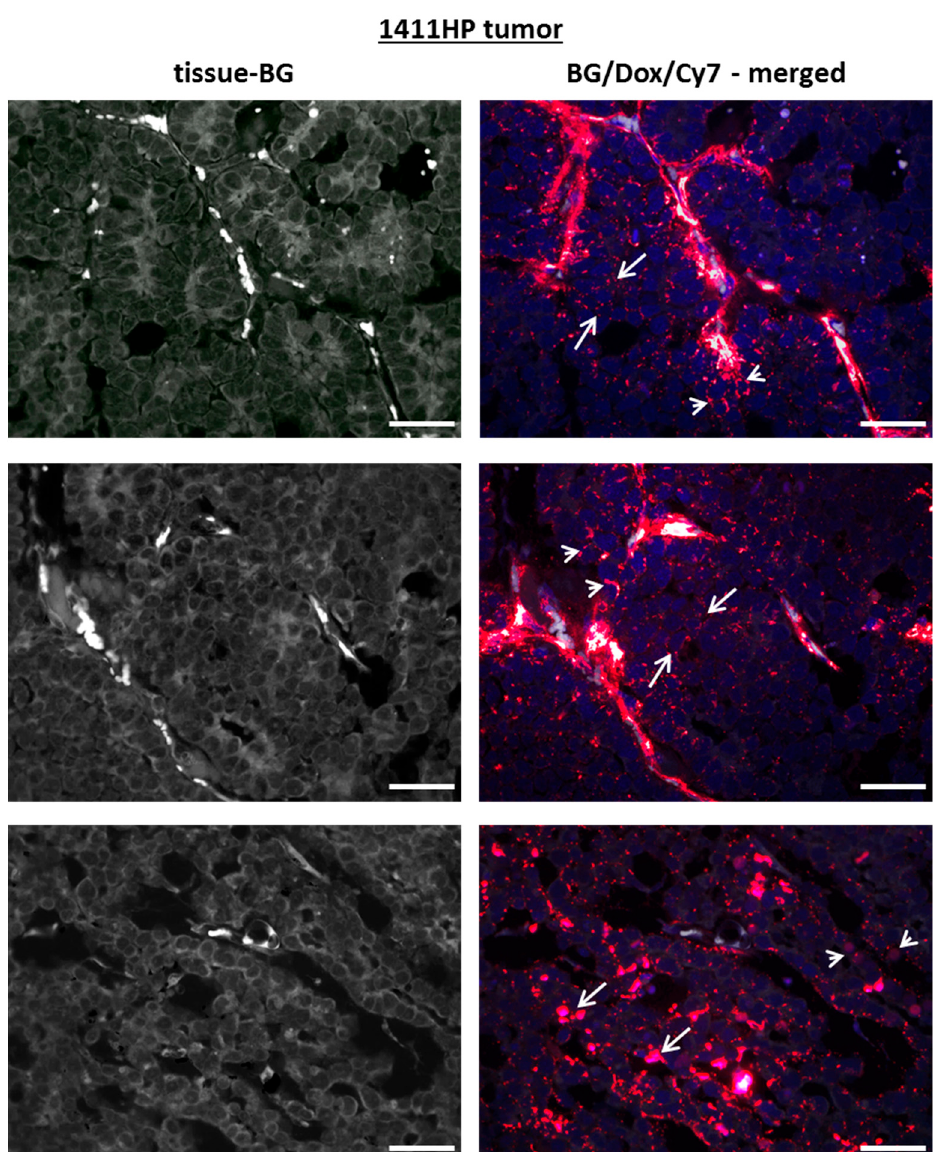
Figure 7. Specific pattern of distribution in the 1411HP tumor type. Depicted are three examples representing the main features of distribution found in the 1411HP tumor type 24 h after injection of the pHPMA-Dox-Cy7 conjugate. Images on the left side show the tissue background, respectively. On the right side, merged images of isolated Dox (blue) and polymer carrier (red) derived signals together with the tissue background are shown, respectively. A substantial amount of the conjugate is still located within vessel structures (upper and middle example) and from there a consistent distribution throughout the tissue seems to occur, eventually resulting in cellular uptake and cleavage reaching the typical pattern of nucleus confined Dox and peripheral polymer (white arrows), including states of cytoplasmic co-localization of Dox and polymer (white arrowheads). Further patterns of the process of distribution can be recognized (bottom example), including the presence of extracellular deposits of uncleaved conjugate (arrow) and nucleus associated combined signals of Dox and polymer (white arrowheads). (Scale bar: 50 µm).